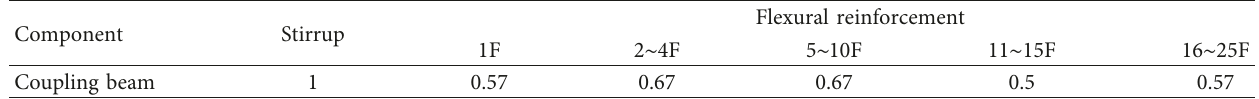
/ ρ in coupling beam. O N